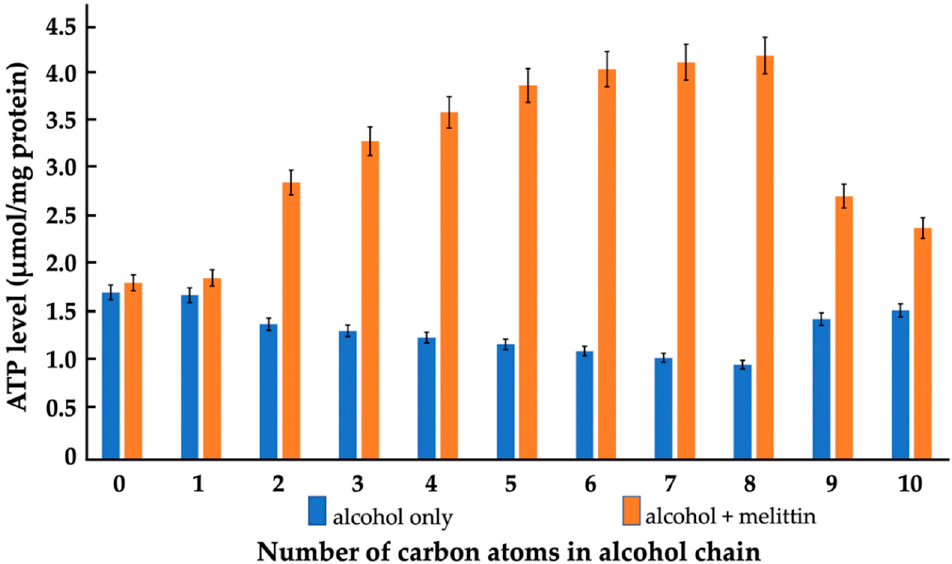
Figure 2. Mitochondrial ATP synthesis of Daphnia pulex as a function of alcohol chain length in the absence of melittin and in melittin-treated organelles. ATP levels were assessed as µ mol ATP synthesized per mg of mitochondrial proteins. Mitochondria were treated with either alcohols, melittin or a mixture of alcohol and melittin as described in the Materials and Methods. The bulk phospholipid concentration in the mitochondrial samples, estimated via comparing the integrated areas of the 31 P NMR signals to that of large multilamellar liposomes, was approximately 1.65 × 10 − 2 M. Concentrations of alcohols and melittin were 1.65 × 10 − 3 M and 1.65 × 10 − 4 M, respectively. Blue and orange bars at 0 on the horizontal axis show, respectively, the ATP levels in the control sample and in sample treated with melittin in the absence of alcohol. Each data point is the mean of three independent experiments. Standard deviations, shown as error bars, were within 5.2% of the means.